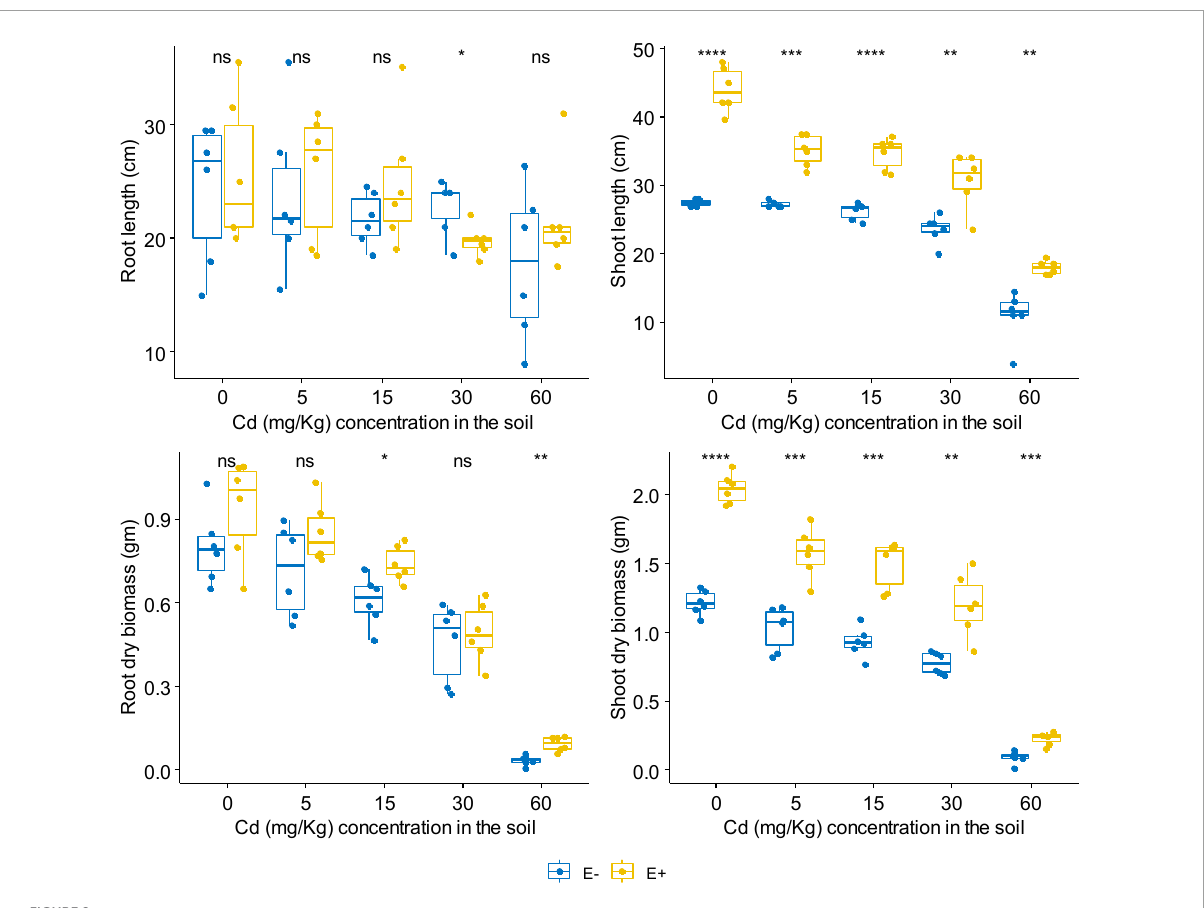
FIGURE2 The effect of FXZ2 on the growth of Dysphania ambrosioides under Cd stress (* p < 0.05, ** p < 0.005, *** p < 0.0005, **** p < 0.00005, ns p > 0.05 t